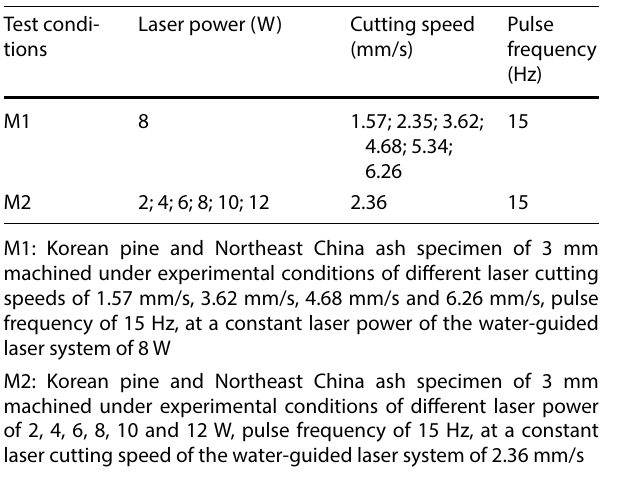
Table 4 WJG Nd: YAG laser wood machining conditions